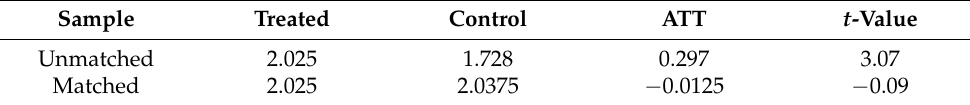
Table 6. ATE of early technology adoption on new technology adoption